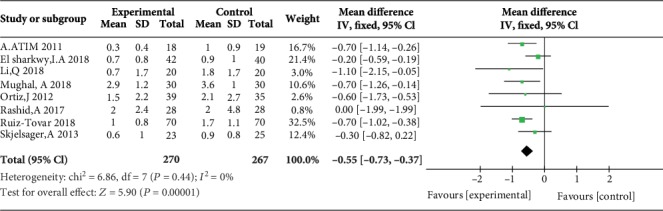
Postoperative pain scores at rest at 24 h.